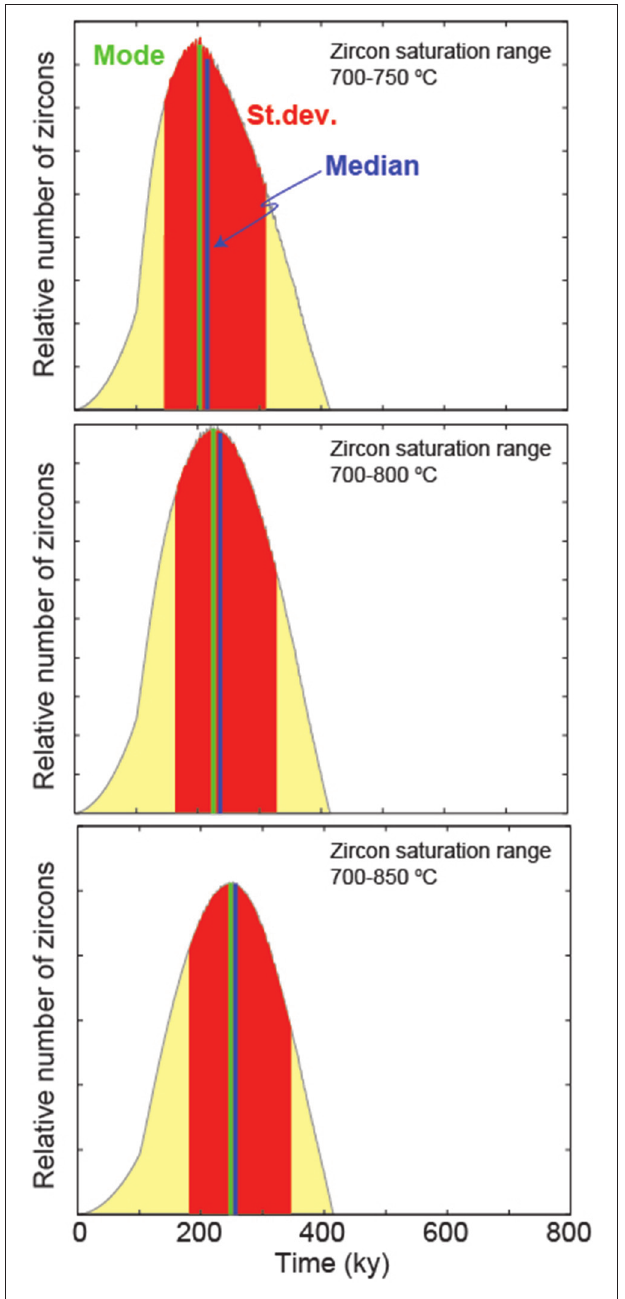
FIGURE 5 | Mode, median, and standard deviation of population of zircon crystallization times obtained for a constant magma flux of 0.01 km 3 /y, final volume of 1000 km 3 , and different ranges of zircon saturation